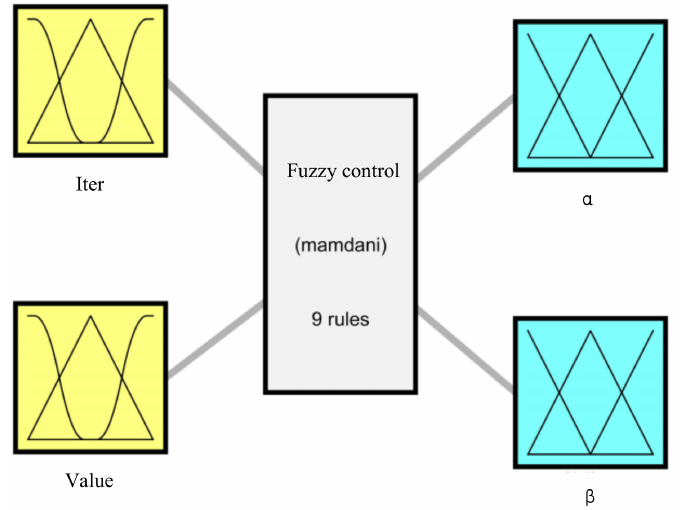
Figure 3. Framework of the fuzzy